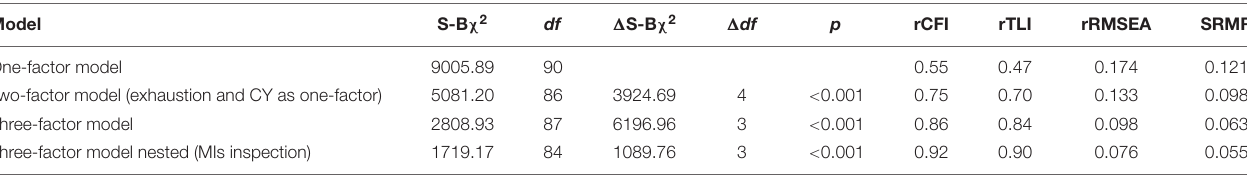
TABLE 2 | Fit indices of the MBI-SS from the CFA. Model